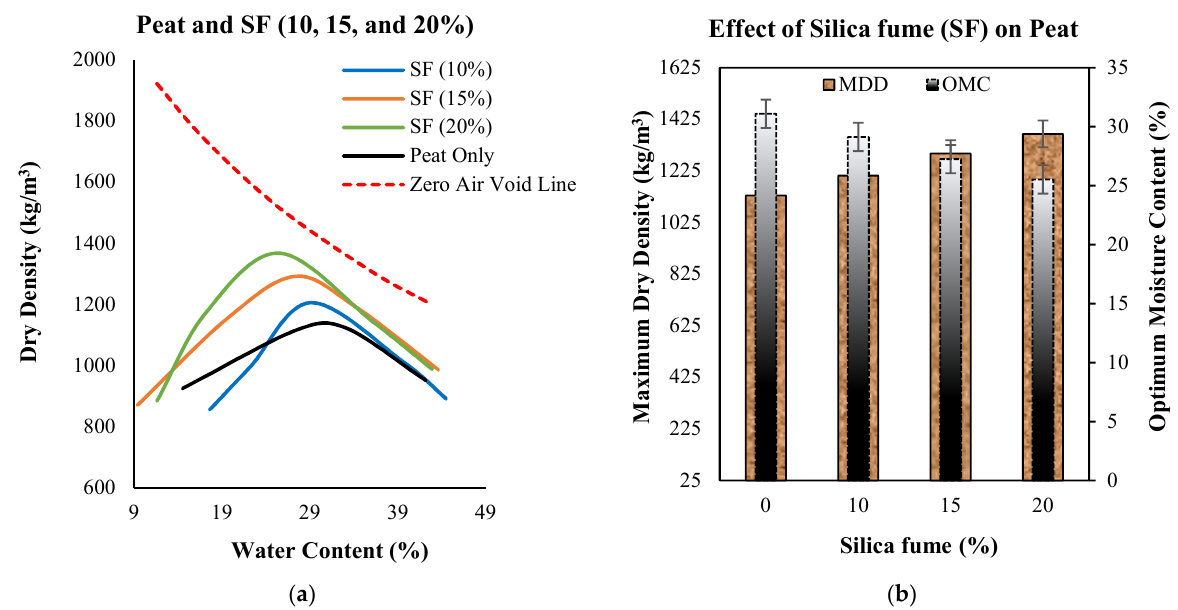
Figure 1. ( a ) Standard compaction curves of untreated and treated peat with 10%, 15%, and 20% SF; ( b ) effects of increasing SF dosage on the dry density and W opt of treated peat.